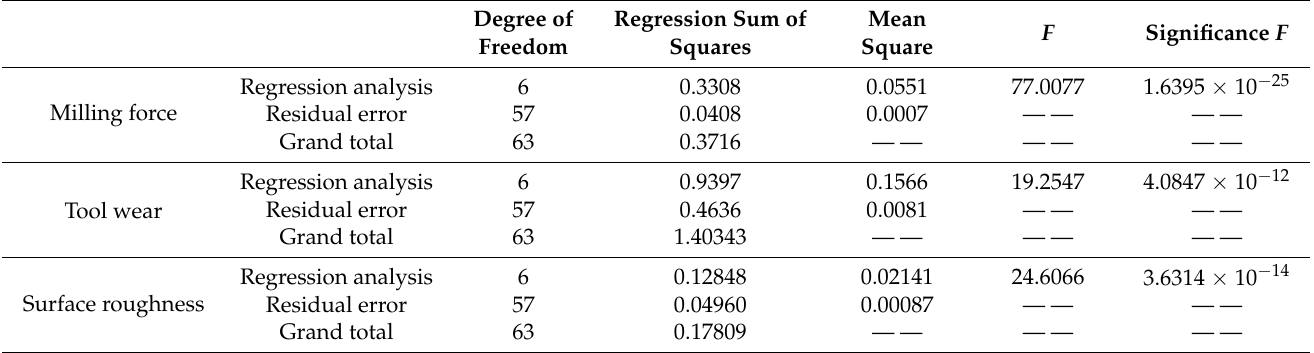
Table 6. Variance analysis of empirical regression